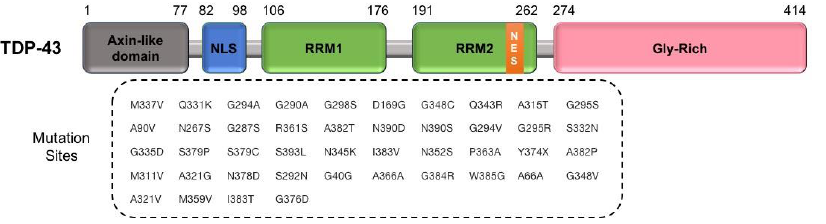
Figure 5. A scheme for exhibiting variants sites in TDP-43 protein: (Top) the TDP-43 domain structure; and (Bottom) the 44 TDP-43 variants shown in patients with ALS. NLS, nuclear localization signal; NES, nuclear export signal; RRM, RNA recognition motif.